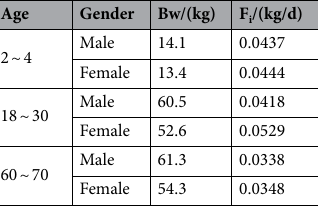
Table 4. The F i and body weight of apricot for different age groups in China.